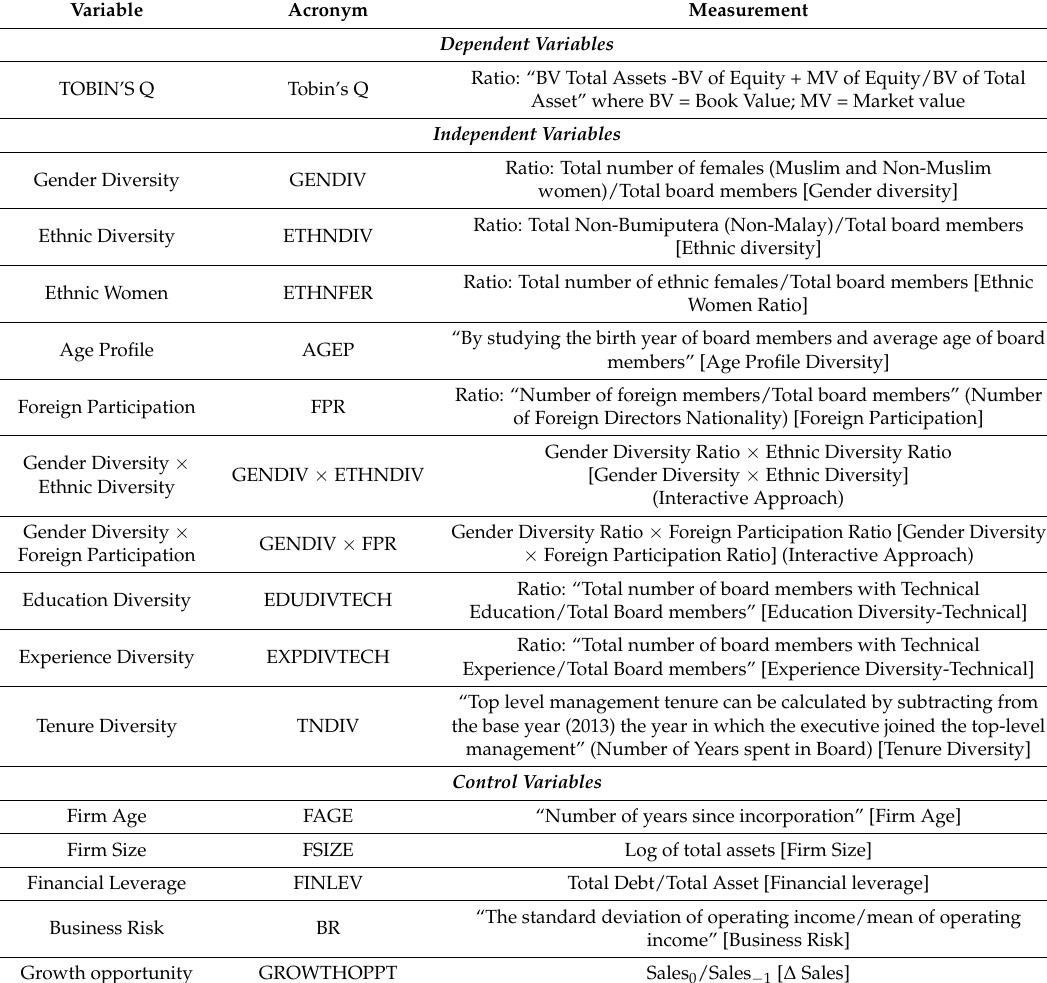
Table 1. Operationalization of